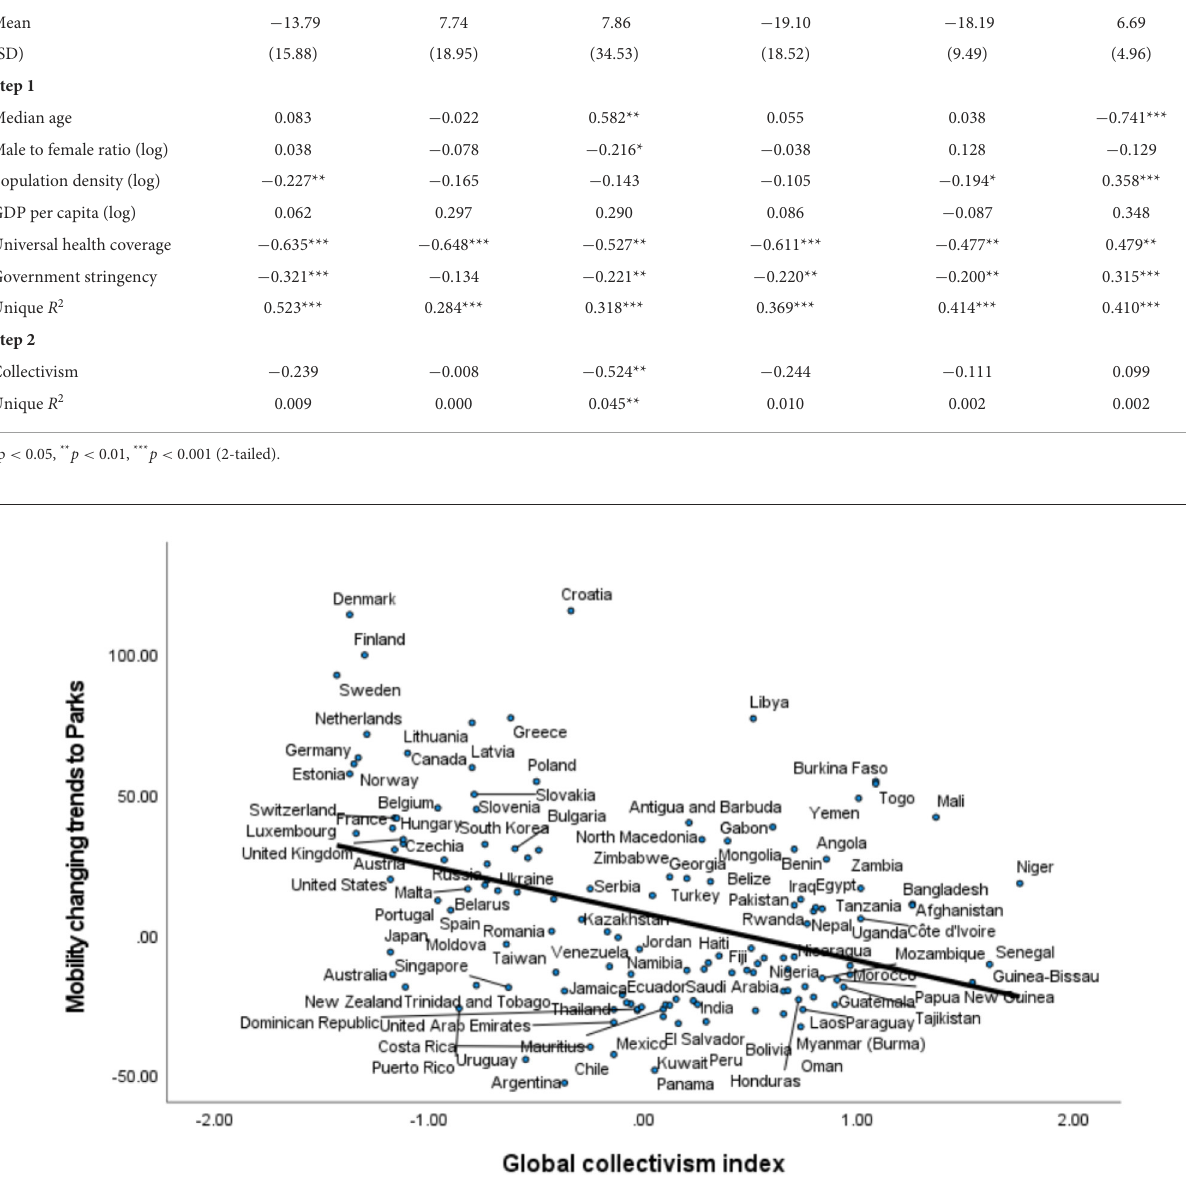
TABLE 2 Hierarchical regression results (standardized coefficients) of mobility changing trends on control variables and collectivism at the country/territory level ( n = 123). Retail and Grocery and recreation